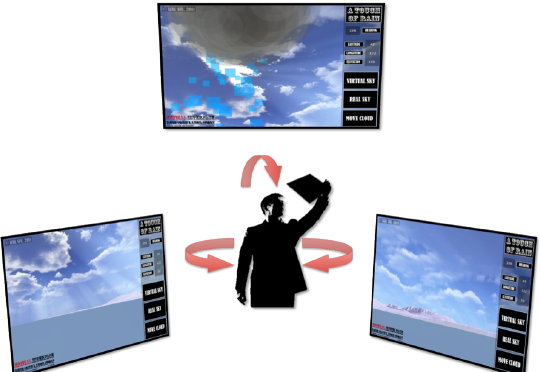
Figure 6. A situated virtual environment interface – using a location-aware, camera-equipped, sensor-enabled tablet to ‘look through’ a portal into a virtual world at the same scale as the real world. The user can move the tablet to look around at data visualizations of the space they are standing in.